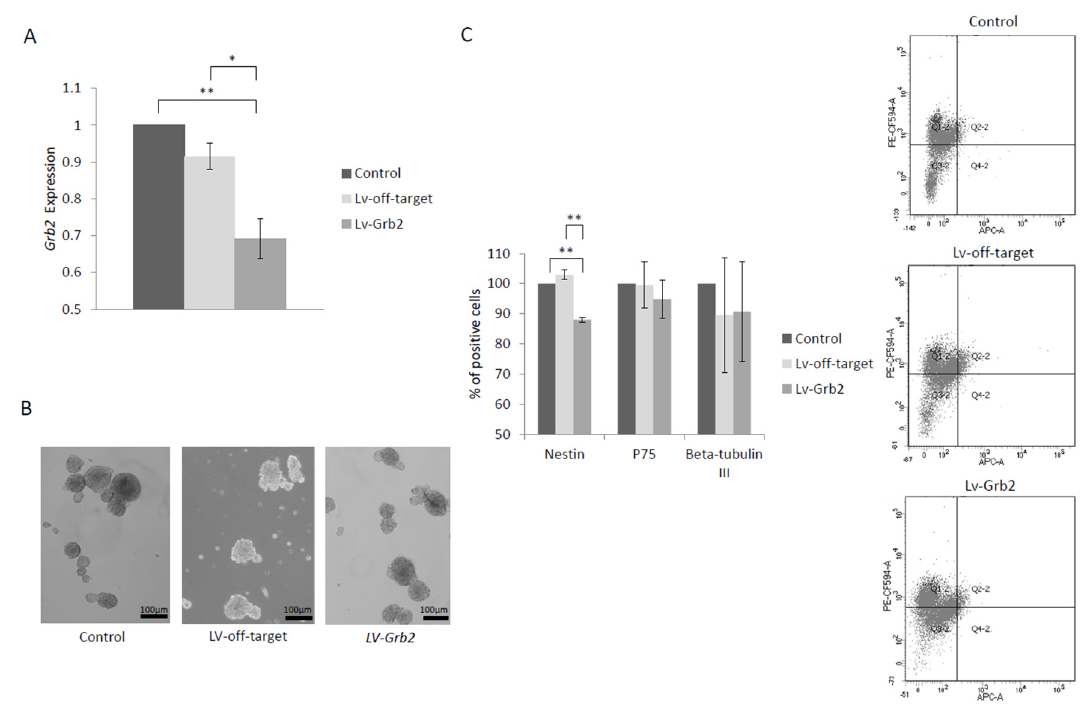
Figure 2. Functional role of Grb2 in NLB cultures. ( A ) Grb2 expression on mouse enteric precursor cells’ (EPCs) Grb2 downregulation. Uninfected group (control), small hairpin RNA (shRNA) non-target control group (LV-o ff -target), and infected group (LV- Grb2 ). p -value control / LV- Grb2 = 0.0017; LV-o ff -target / LV- Grb2 = 0.02. ( B ) E ff ect of LV- Grb2 on the size and number of NLB cultures. ( C ) E ff ects of LV- Grb2 on the cell phenotypes derived from NLBs (EPCs that express Nestin, Beta-tubulin III, or p75 markers). For Nestin, p -value control / LV- Grb2 = 0.002; LV-o ff -target / LV- Grb2 = 0.003. A representative image of the decrease of Nestin-expressing cells (PE-CF594-A + ) in LV- Grb2 condition detected by flow cytometry is shown on the right side. Fluorochrome APC-A corresponds to Beta-tubulin III marker. * p value < 0.05, ** p value < 0.01 and *** p value <